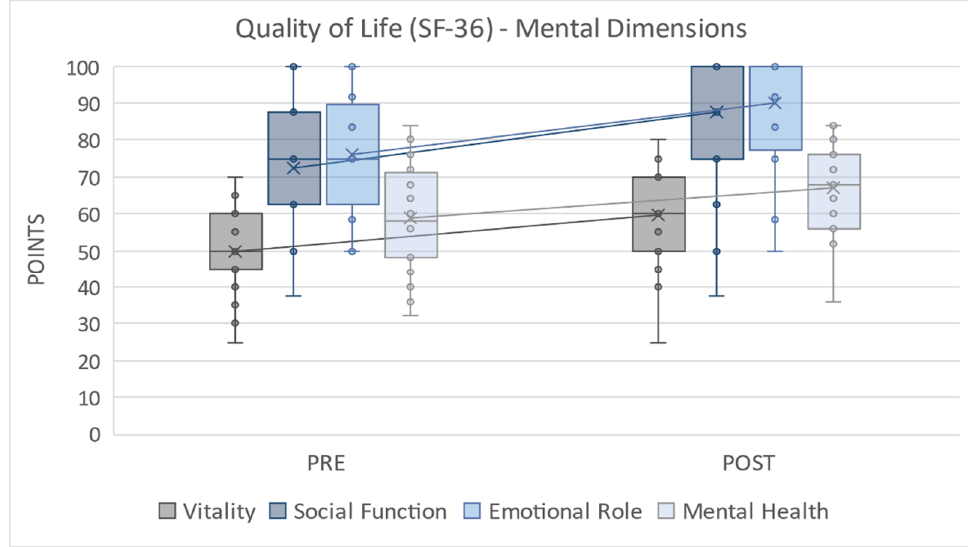
Figure 2. Quality of Life (SF-36)—Mental Dimensions; PRE = pretest; POST = posttest.